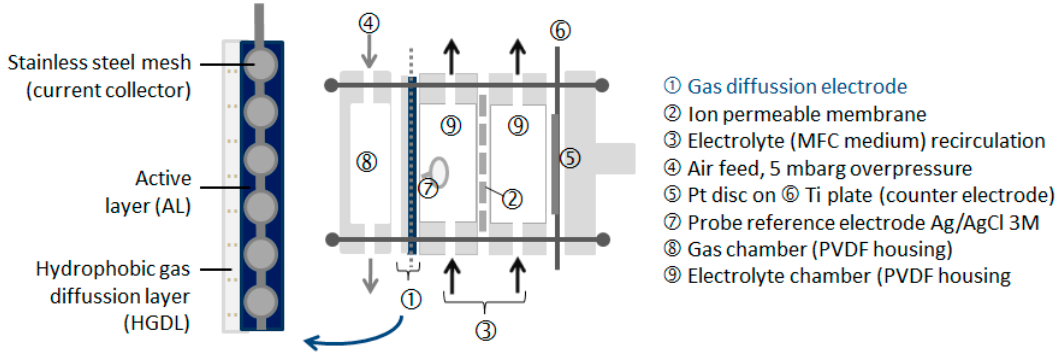
Figure 8. Schematic representation of the cathode half-cell and cross section of the electrode (inset).